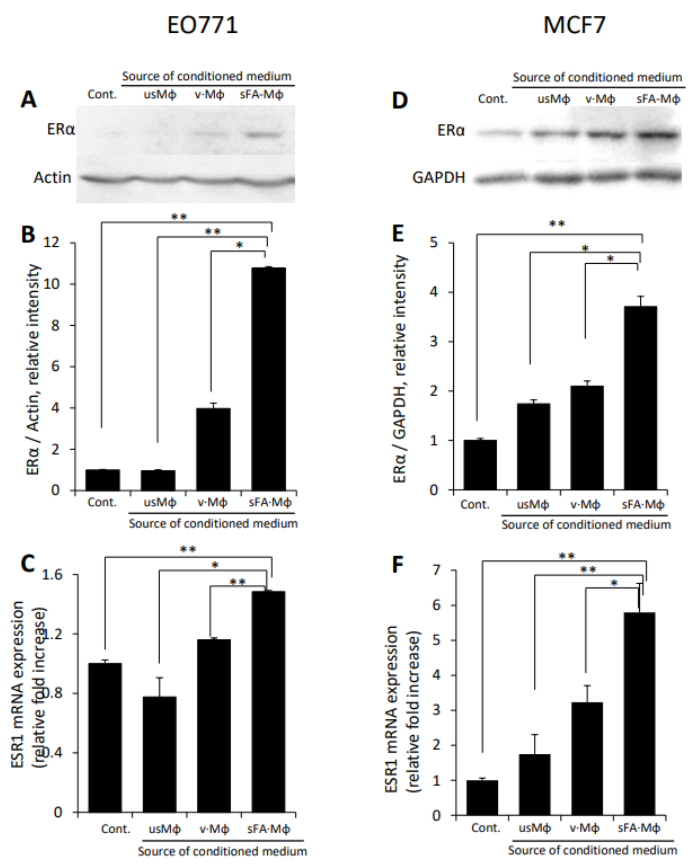
Figure 2. Upregulation of ER α expression in murine and human BC cells by SFA-stimulated macrophages. E0771 ( A – C ) and MCF-7 ( D – F ) BC cells either remained untreated (Cont.) or were incubated (24 h, 37 ◦ C) with medium conditioned by either unstimulated macrophages (usM φ ), or macrophages stimulated (16 h) by vehicle (BSA) alone (v · M φ ) or by SFA (i.e., palmitic acid) conjugated with fatty acid free-BSA at a 2:1 molar ratio (SFA · M φ ). ( A , D ) ER α protein levels were determined by immunoblotting. ( B , E ) The band intensity was quantified using ImageJ software; intensity ratio for ER α /actin or ER α /GAPDH is shown. ( C , F ) The expression of mouse ( C ) and human ( F ) ESR1 gene, encoding for ER α , was determined by qRT-PCR. The data shown are representative of ≥ 3 independent experiments; error bars represent ± SD. * p < 0.02; ** p < 0.0015. Since M ϕ activation by SFA under the obese state involves a TLR4-dependent mechanism [35,37,39,71], we next tested the effect of TLR4 inhibition on the ability of SFA- stimulated M ϕ to induce ER expression. As shown in Figure 3A,B, specific TLR4 inhibitor TAK-242 abolished the ability of SFA-stimulated M ϕ to induce ERα expression in E0771 (A) and MCF7 (B) cells, in agreement with TLR4-activating properties of SFA [37 – 39]. Of note, the canonic ligand of TLR4 lipopolysaccharide [LPS] per se is a component of the systemic obese milieu, since it is chronically present (at extremely low levels, typically ranging between 0.01 to 0.2 ng/mL) in the circulation of obese individuals /experimental animals [74 – 76]. This phenom enon, known as ‘metabolic endotoxemia’ [74 – 76], occurs due to impaired intestinal permeability under obese conditions [74 – 78]. Interestingly, we found that medium conditioned by M ϕ stimulated by LPS at a concentration reflecting metabolic endotoxemia (i.e., 0.1 ng/mL) also upregulated ER in